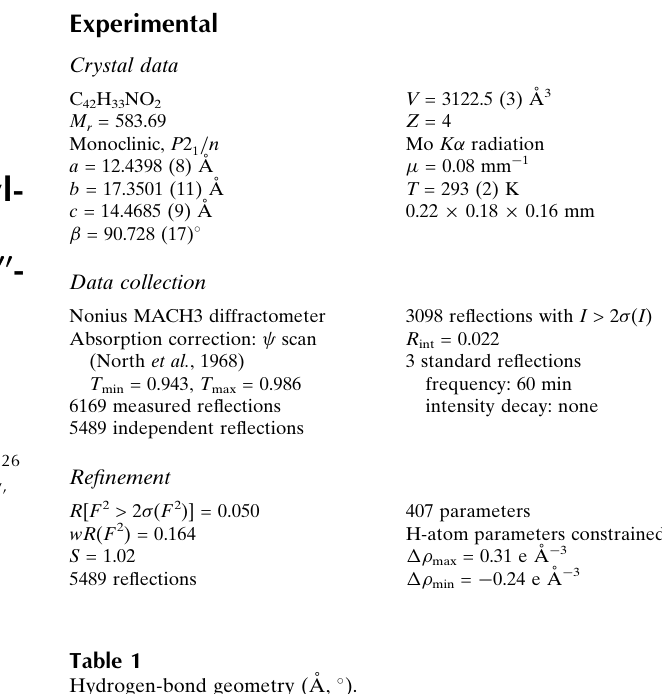
Hydrogen-bond geometry (A˚ , (cid:2)